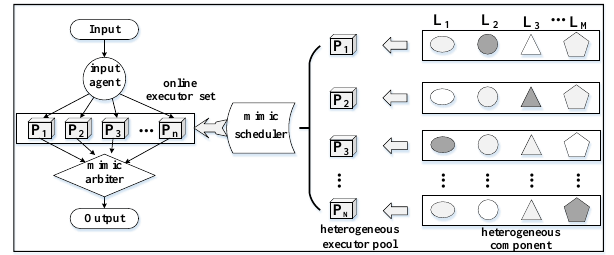
Figure 1. The Schematic diagram of DHR structure.